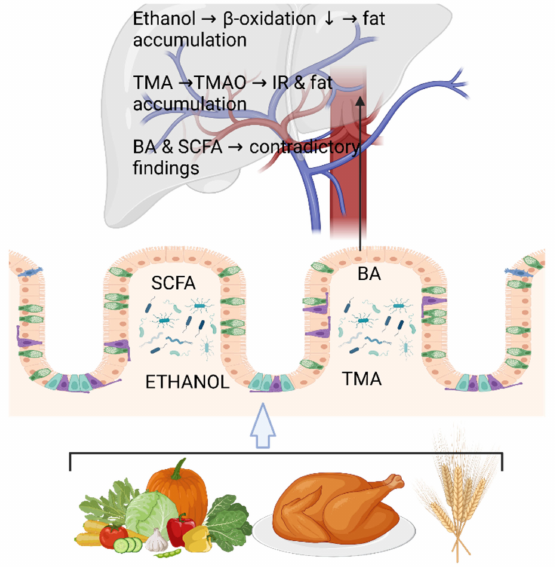
Figure 1. The abundance of many members of the gut microbiota affects the human physiology by processing the ingested food into certain bioactive metabolites. These molecules can act as inter-tissue signaling messengers by penetrating the portal vein and subsequently, the liver, to promote or prevent hepatic fat accumulation. For instance, dietary fiber is metabolized by the gut microbiota into short- chain fatty acids (SCFA, mainly butyrate, acetate, and propionate), and ethanol is produced from dietary carbohydrates. Gut microbiota produce trimethyl amine (TMA) from dietary choline, which is mainly derived from meat, yolk, and dairy products. TMA is further converted into trimethyl amineoxide (TMAO) in the liver. Primary bile acids (BA) are synthesized in the liver, stored in the gallbladder, and then released into the gut, where they are converted into secondary BA by the gut microbiota. In the liver, ethanol can increase fat accumulation by reducing beta-oxidation. TMAO has been shown to induce insulin resistance (IR) and further fat accumulation in the liver. Controversial findings on the role of BA and SCFA in hepatic fat accumulation exist. These will be reviewed in this article. The figure was created using